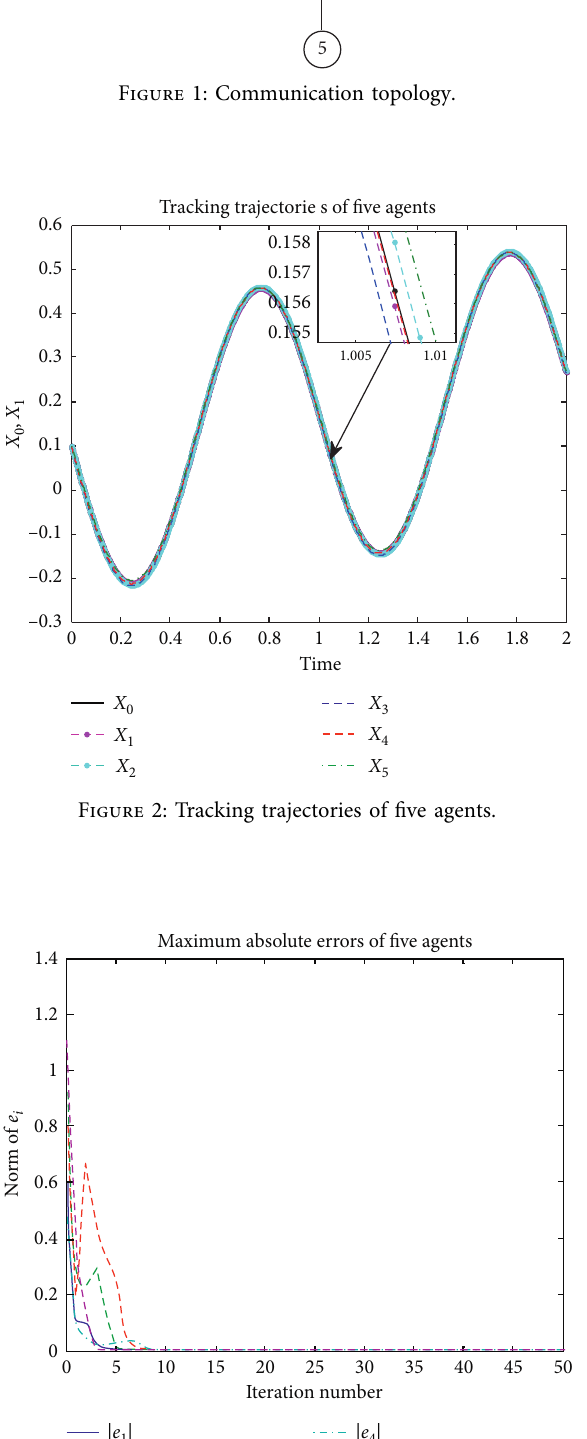
Figure 3: Maximum absolute errors of five